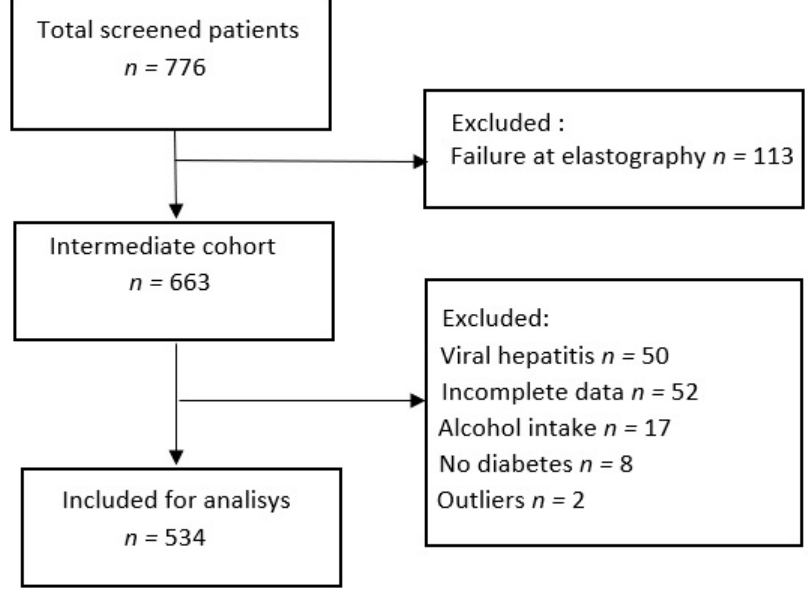
Figure 1. Study flow diagram. A total of 242 patients were excluded from the